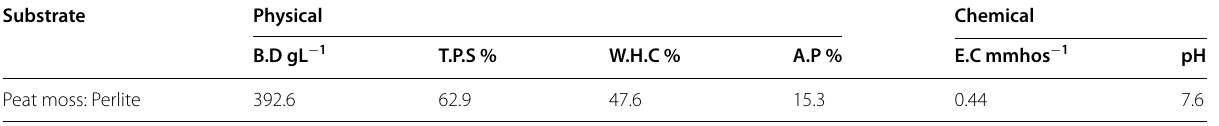
where: B.D is the bulk density, T.P.S is the Total Pore Space, W.H.C is the Water Holding Capacity %, and A.P is the Air Porosity %